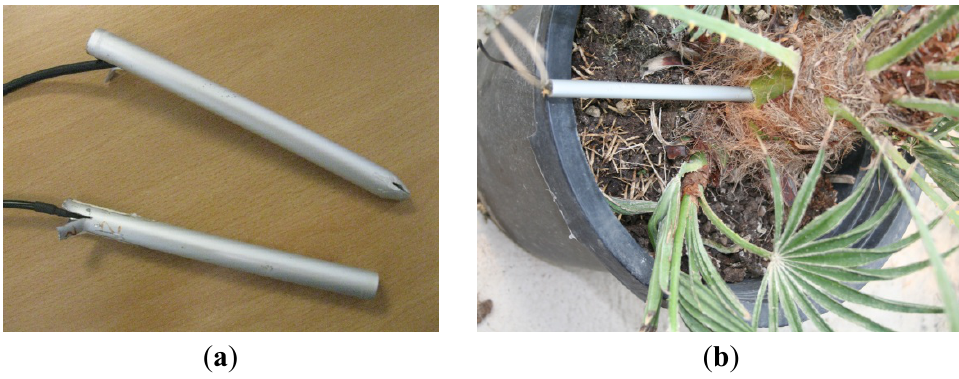
Figure 4. Open and Closed probes ( a ). Example of probe insertion ( b